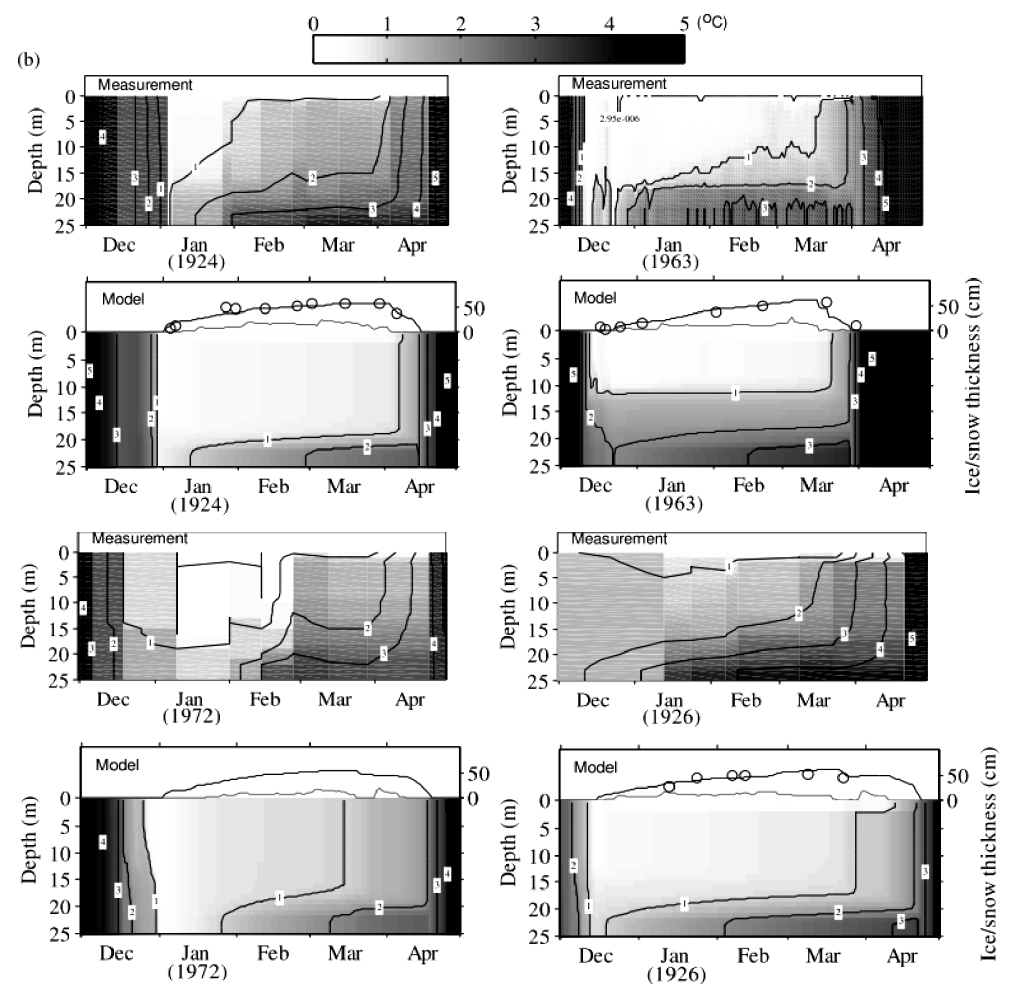
Figure 8. Comparison between the measured and simulated water temperatures and ice/snow thickness under the cold epilimnetic year (1924), warm epilimnetic year (1963), cold hypolimnetic year (1972), and warm hypolimnetic year (1926) in Lake Mendota during the ice-covered period. Time series are simulated ice and snow thickness (solid lines) with measurements (open